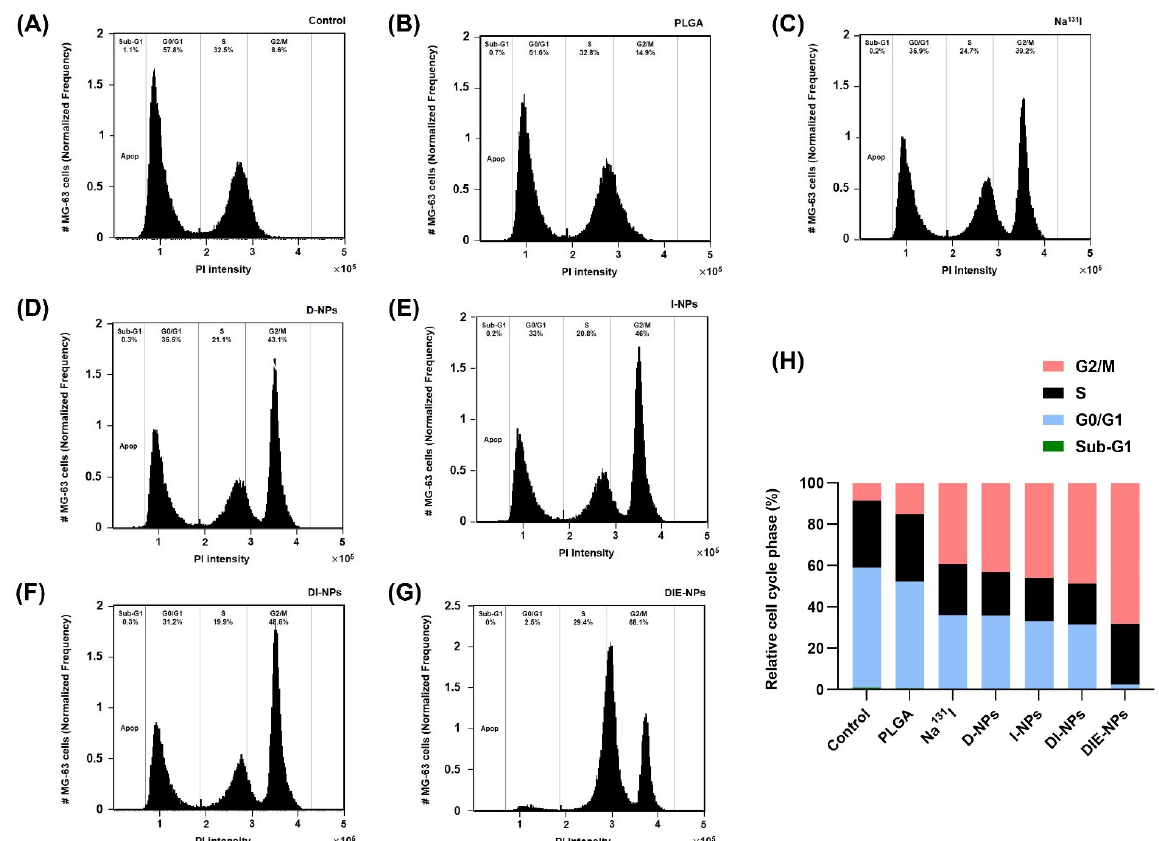
Figure 11. Cell cycle analysis. The number of MG-63 cells (normalized frequency) was assessed us- ing ImageStreamX Mk II flow cytometer after the cell pellets were suspended in the Propidium Iodide (PI) staining solution. The time-dependent impact of the combination formulations on cell cycle progression determined the number of MG-63 in sub-G1, G0/G1, S, and G2/M treated. ( A ) Control. ( B ) PLGA. ( C ) Na 131 I. ( D ) D-NPs. ( E ) I-NPs. ( F ) DI-NPs. ( G ) DIE-NPs. ( H ) Relative cell cycle phase percentages of MG-63 in sub-G1, G0/G1, S, and G2/M treated control, PLGA, Na 131 I, D-NPs, I-NPs, DI-NPs, and DIE-NPs.